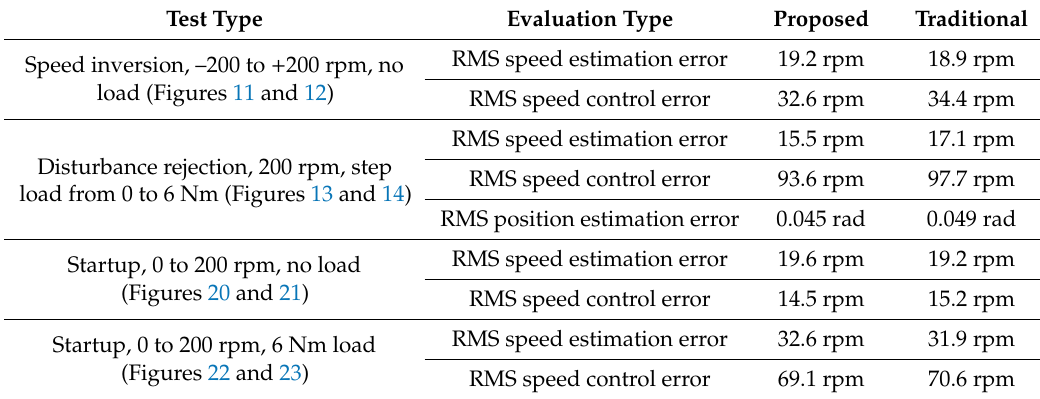
Table 2. Quantitative comparison of error in experimental tests.